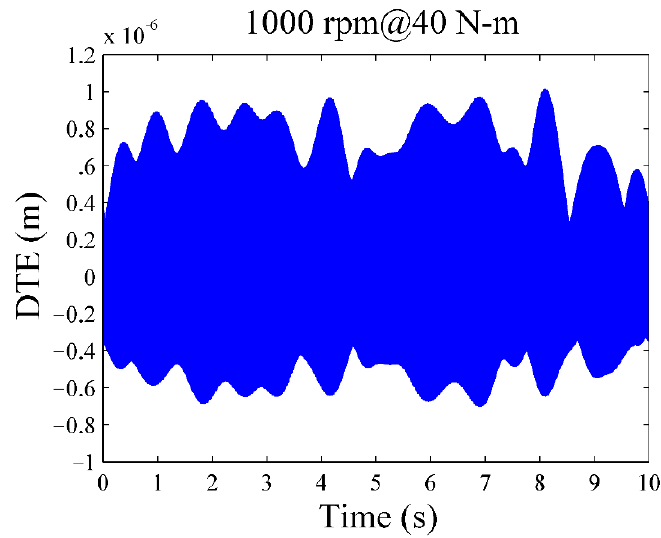
Figure 13. Filtered DTE signal in the time domain.